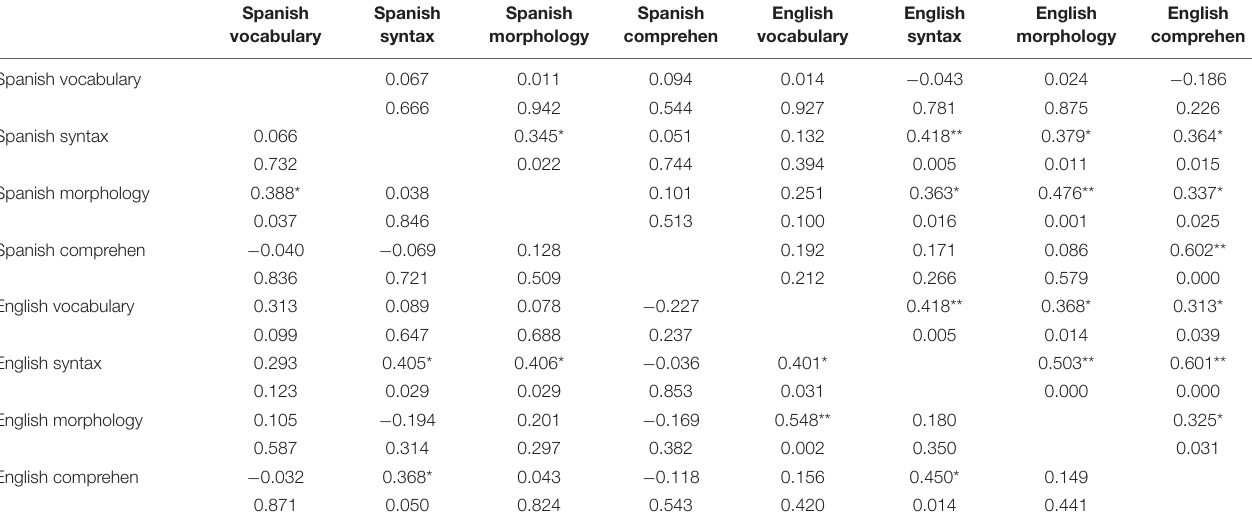
TABLE 3 | Correlation matrix among all the tasks for each